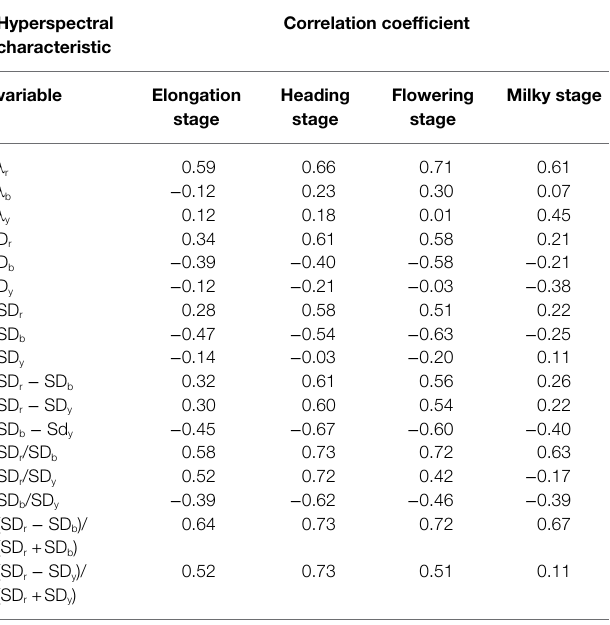
TABLE 4 | Correlation analysis between spectral characteristics variable and rice yield at different stages.